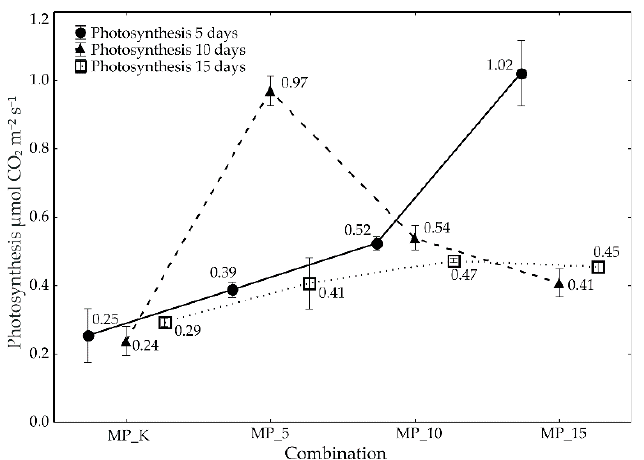
Figure 3. Intensity of the course of photosynthesis in the set time intervals in oilseed rape with different numbers of foraging aphids of M . persicae . Vertical lines at mean values indicate SE.